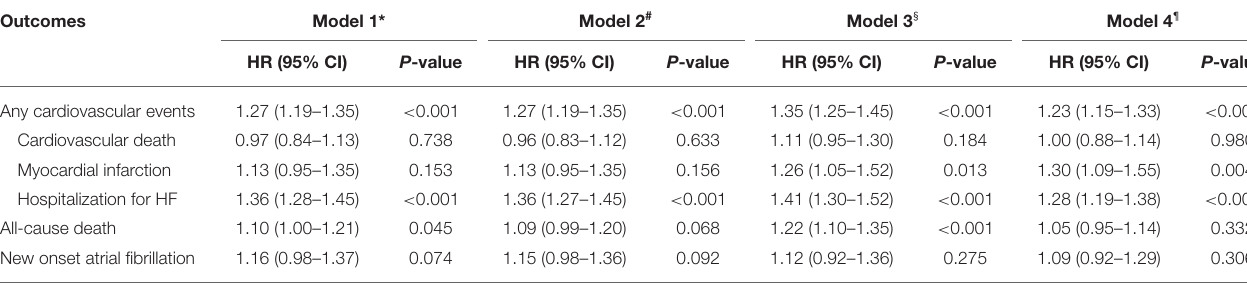
TABLE 2 | Risk of outcomes in per 1-SD change of body-weight variability. Outcomes